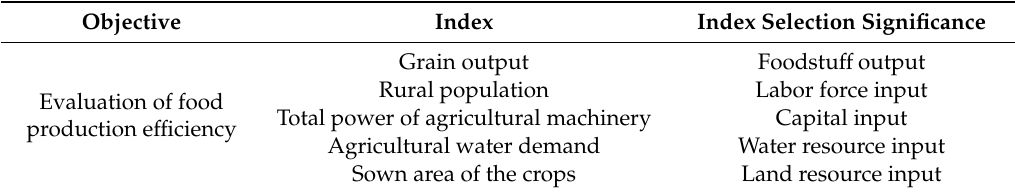
Table 1. Evaluation index of grain production e ffi